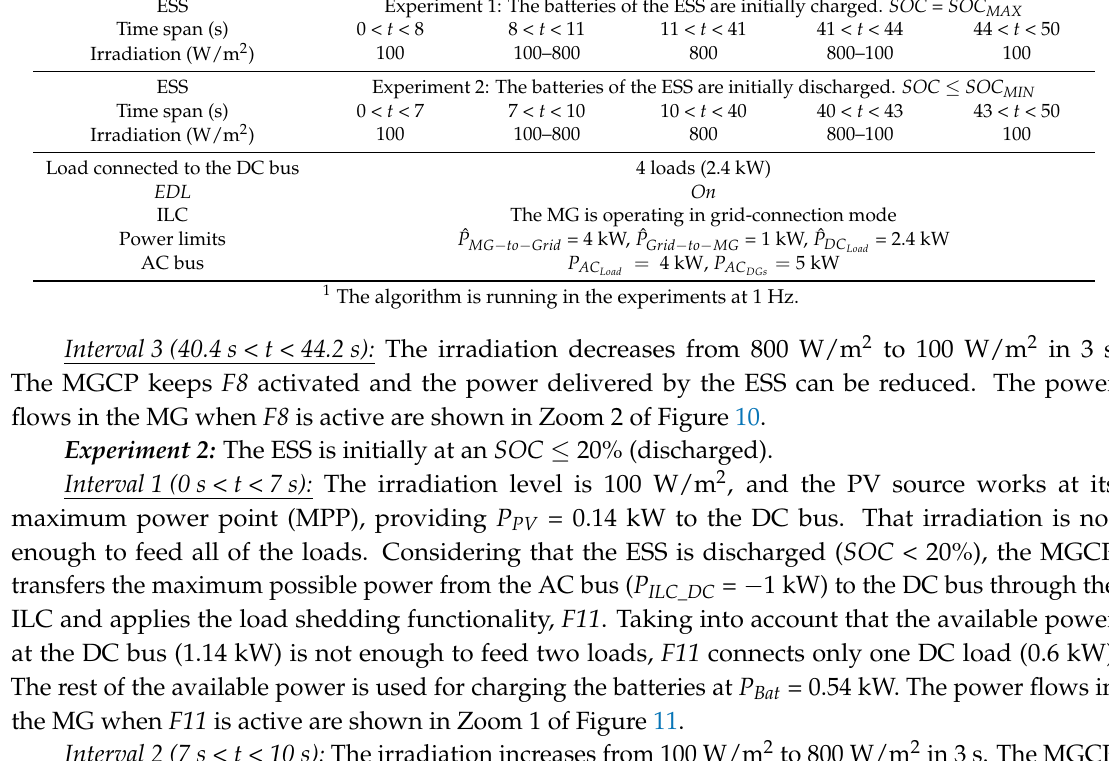
Table 4. The experimental scenarios of the MG. Experimental Scenarios